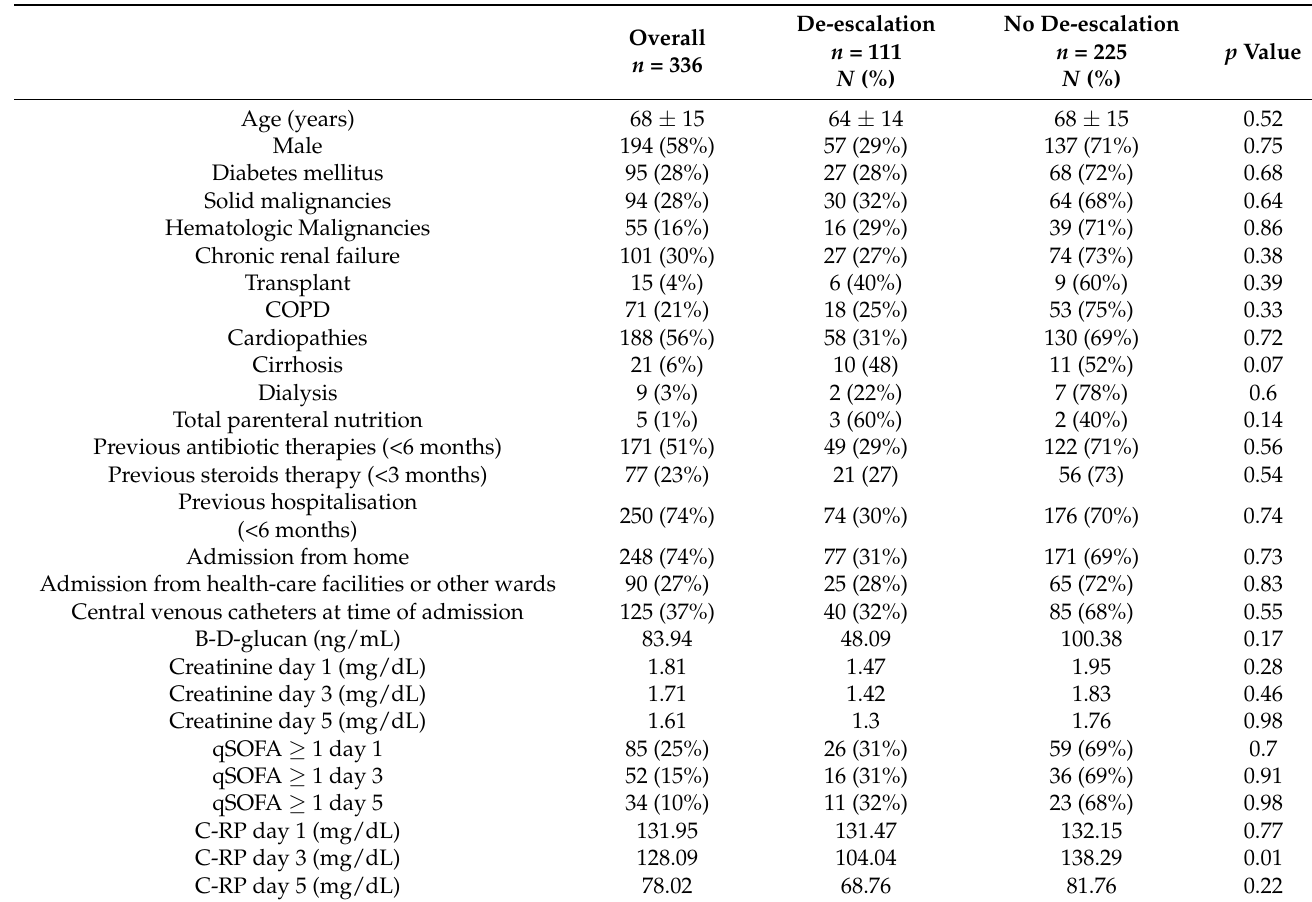
Table 1. Characteristics of patients according to de-escalation rate at day